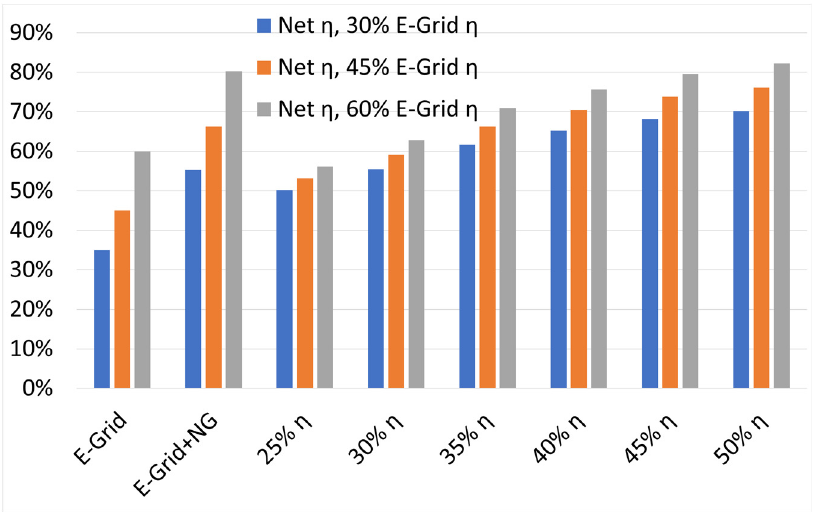
Figure 6. Combined energy efficiency of cogeneration system-based configurations with different prime power electrical efficiencies. Combined load of 28 kWh/day, 0.5 kW PV, 0.4 kW PM, and 2 kWh electrical storage capacitance.